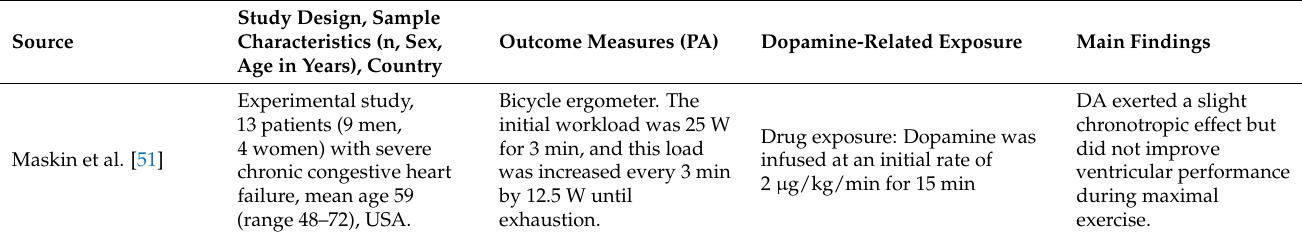
Table 3. Characteristics and the main results of studies analysing the effect of dopamine on physical activity and exercise.